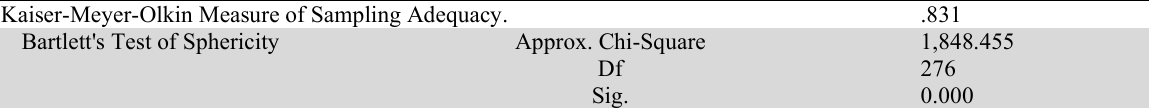
KMO and Bartlett's Test Kaiser-Meyer-Olkin Measure of Sampling Adequacy.